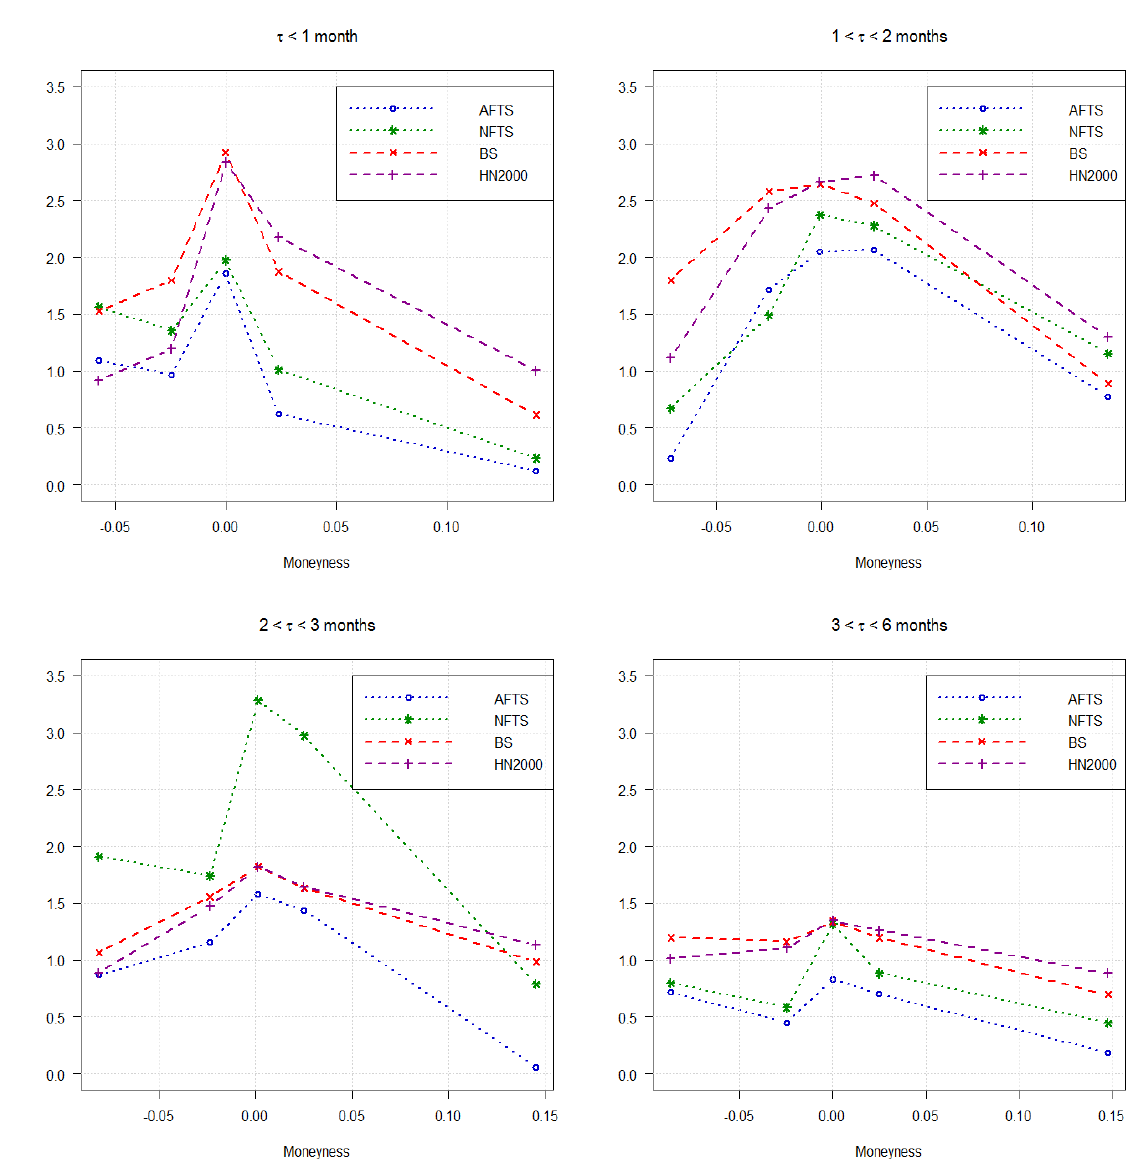
Figure 5. Hedging absolute errors as a function of